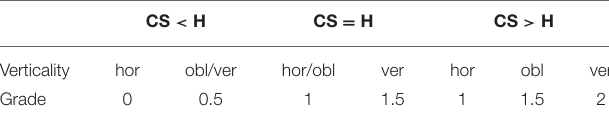
TABLE 2 | Evaluation of the criterion C1, based on the verticality and roundness of the hippocampal body in a coronal view. Roundness/verticality Horizontal Oblique Vertical Flat 0 0.5 NA Round 0.5 1 2 Oval 1 1.5 2 NA, not applicable. Grades are between 0 and 2.